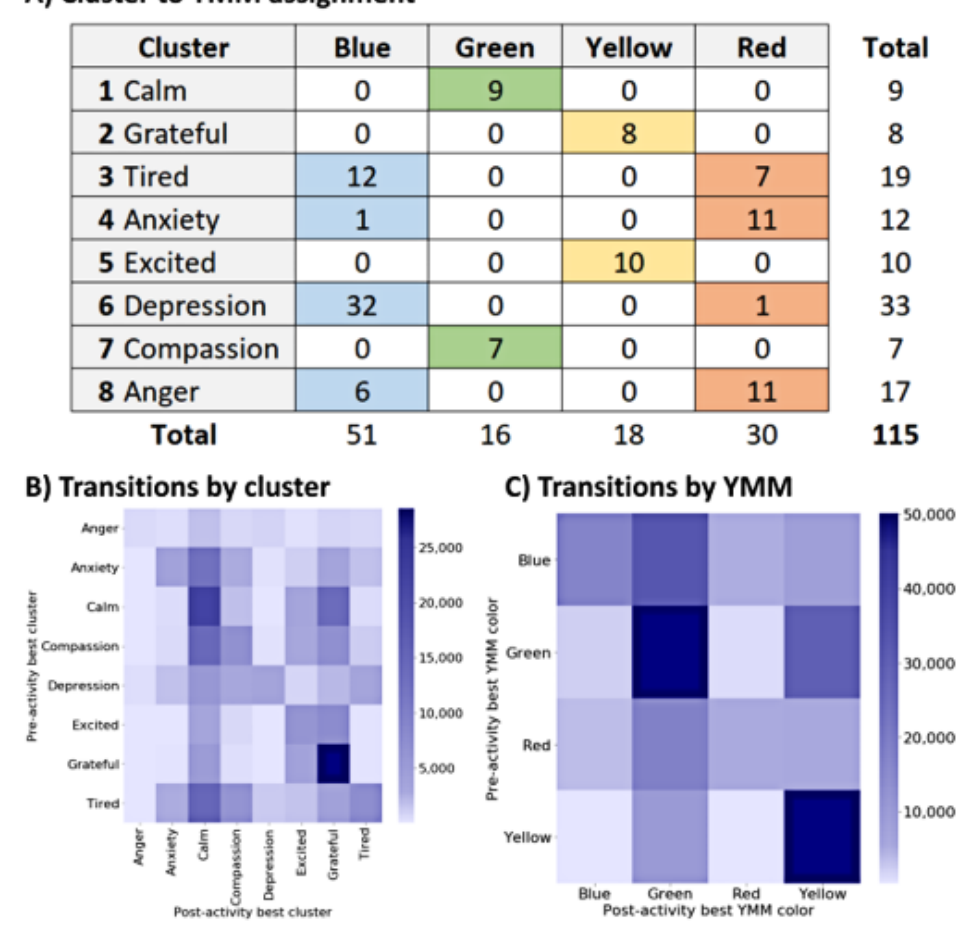
Figure 4. Cluster alignment and pre– to post–mindfulness and meditation activity (MMA) transitions. Clusters were assigned to the Yale Mood Meter (YMM) quadrants based on the majority of emotions within that cluster that corresponded to a YMM quadrant (eg, the “tired” cluster is blue in YMM). (A) Counts of all 115 endorsable emotions in the Stop, Breathe & Think app by each cluster and the YMM quadrant they are associated with. (B) Session counts for transitions from the pre-MMA emotional cluster to the post-MMA emotional state. Calm and grateful clusters were the most frequent post-MMA states. (C) Session counts for transitions from the pre-MMA emotional YMM quadrant to the post-MMA emotional